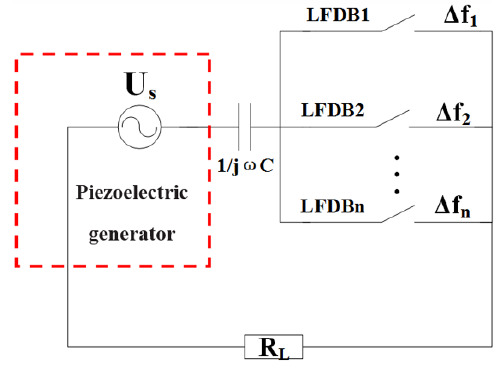
Figure 3. Equivalent circuit of the novel ropes ‐ driven wideband VEH system.